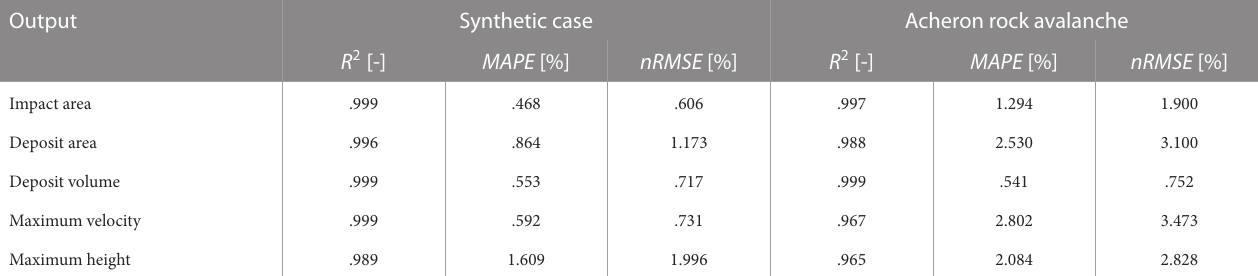
TABLE2 Coefficientofdetermination, R 2 ,meanabsolutepercentageerror, MAPE ,andnormalisedrootmeansquarederror nRMSE fortheemulatorstrainedwith